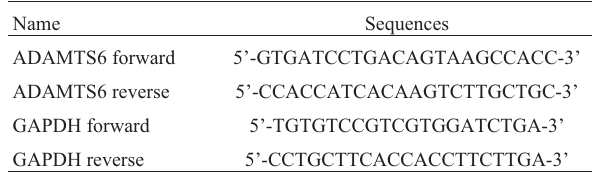
Table 2 - The primers utilized in